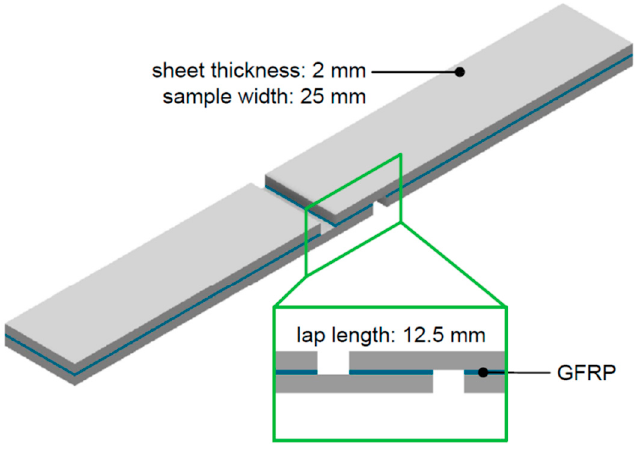
Figure 6. Sample for testing the interlaminar strength of the FML composite in the static tensile/shear Figure6. SamplefortestingtheinterlaminarstrengthoftheFMLcompositeinthestatictensile / sheartest. test.